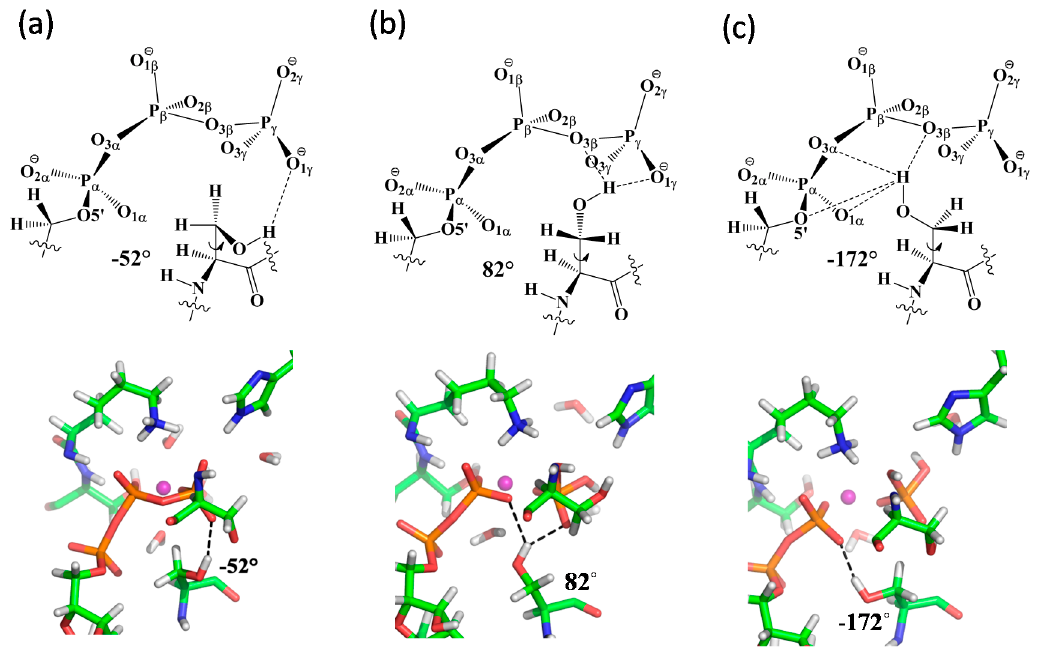
Figure 6. Patterns of H-bonds and representative geometries for the three conformations of the C-loop S607 observed during ATP hydrolysis: in the ( a ) reactant, ( b ) associative phosphoryl transfer transition state (TS3), and ( c ) product regions. The “finger” motion of S607 associated with the three conformations can be characterized by a transition of the dihedral angle d (C-C α -C β -O γ ) in the residue from − 52°, through +82°, to − 172°.